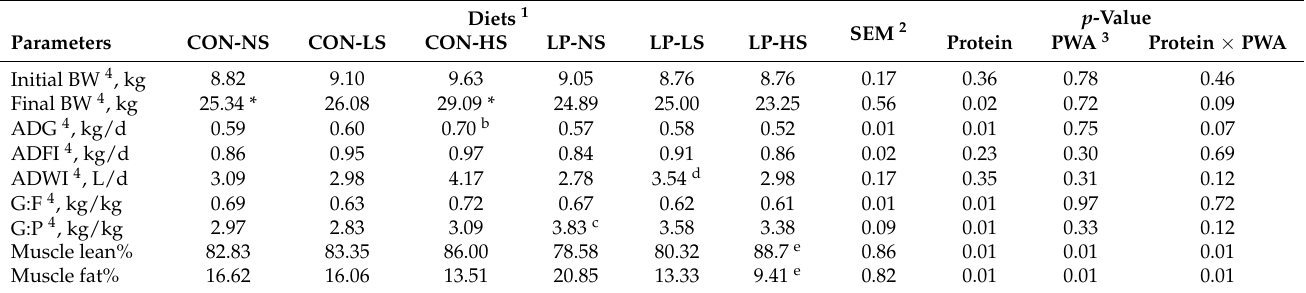
Table 3. Growth performance and muscle fat and lean content of nursery pigs fed with two levels of dietary protein and three levels of a phytogenic water